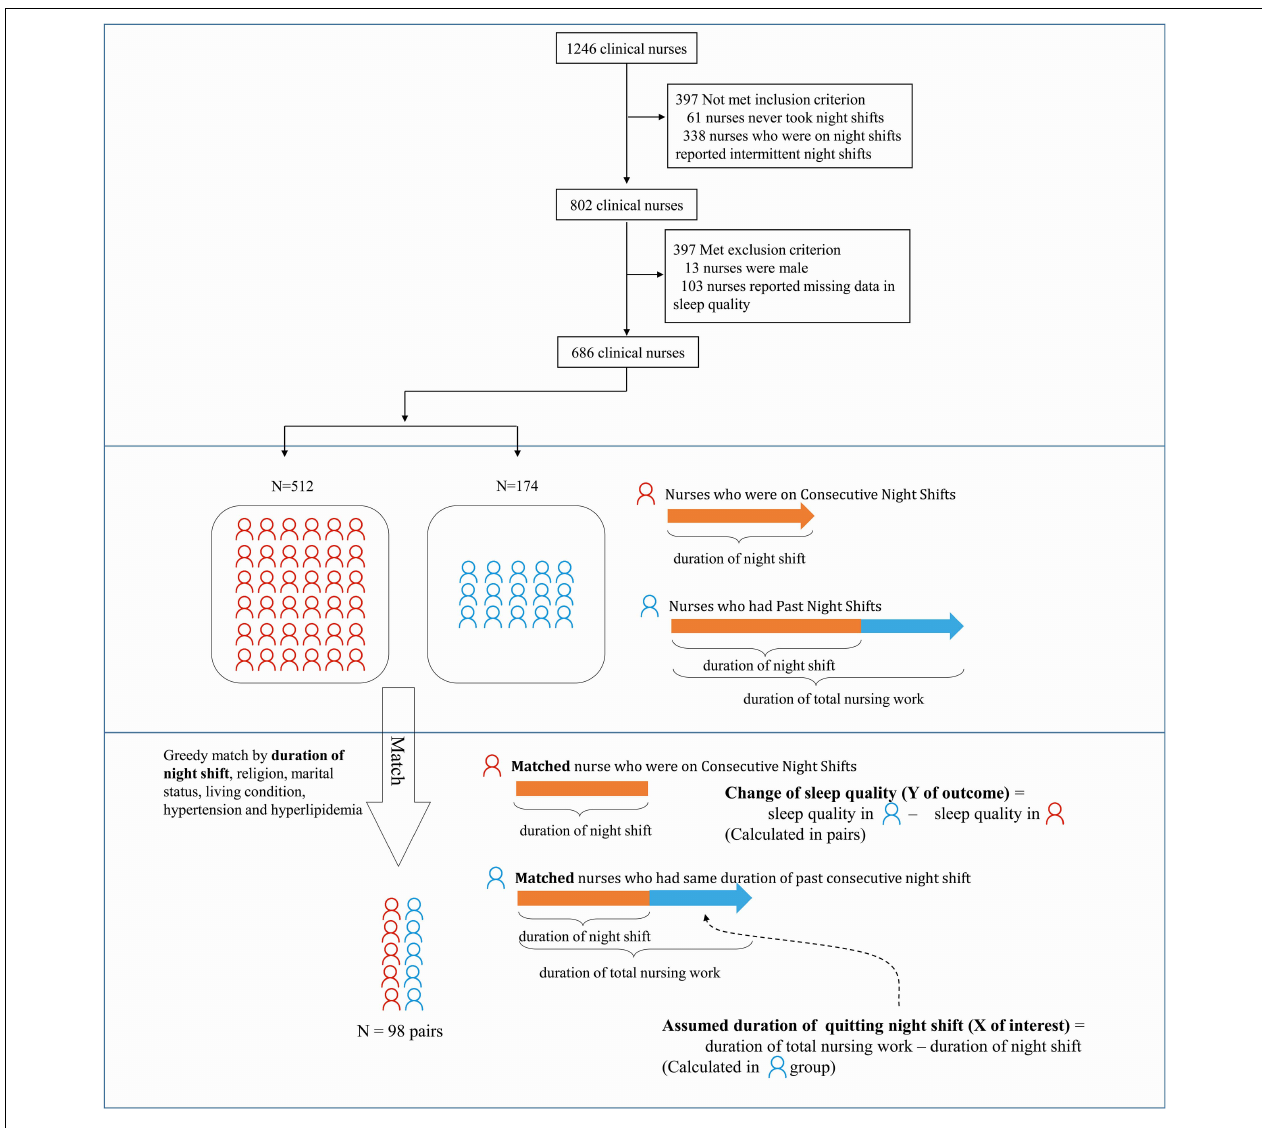
FIGURE 1 | Framework for constructing a hypothetical prospective cohort using greedy